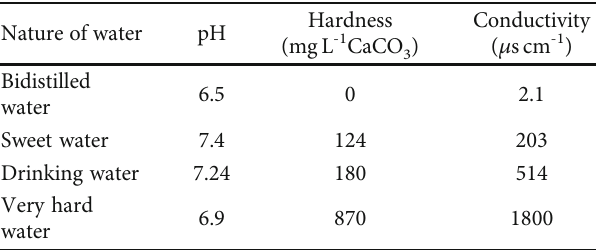
Table 3: Some characteristics of the waters tested. Nature of